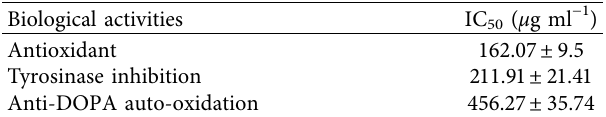
Figure 4: IC 50 of (a) tyrosinase inhibition, (b) antioxidant activity, and (c) anti-DOPA auto-oxidation. Kojic acid, ascorbic acid, BHT, and gallic acid are used as positive controls. Each bar is presented as mean ± SD ( n � 3). Different letters indicate significant difference ( p ≤ 0 . 05). Table 2: Biological activities of G. biloba tea extract in terms of inhibited concentration at 50% (IC 50 ) (mean ± SD, n �